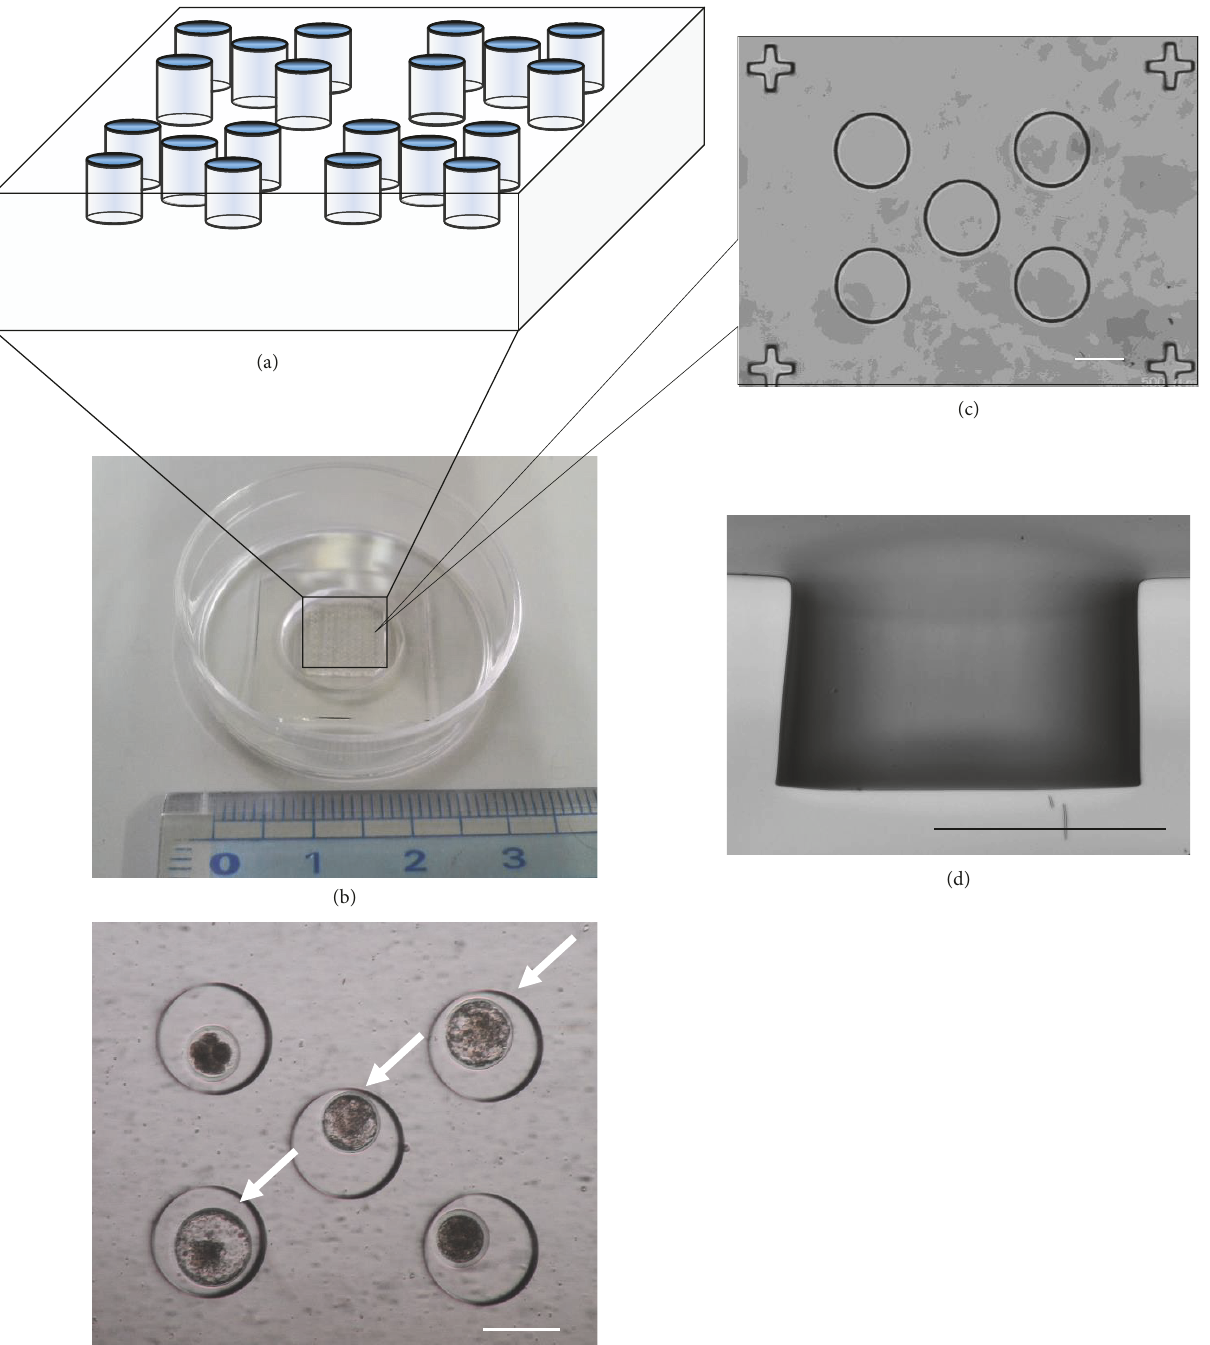
Figure 1: Images of a PDMS MW plate attached on the bottom of a glass-bottom dish. (a) Schematic diagram showing a PDMS MW plate. Some cylindrical MWs were fabricated on the plate surface. (b) Poly(dimethylsiloxane) microwell (PDMS MW) plate was attached to the bottom of a glass-bottom dish by oxygen plasma treatment. (c) Transmission and (d) median section images of the PDMS MW. The cylindrical MW was 300 𝜇 m in diameter and 200 𝜇 m in depth. (e) One bovine embryo was introduced into each PDMS MW. Blastocysts (arrow) were observed in the PDMS MW after 7 days of culture. Scale bar: 200 𝜇